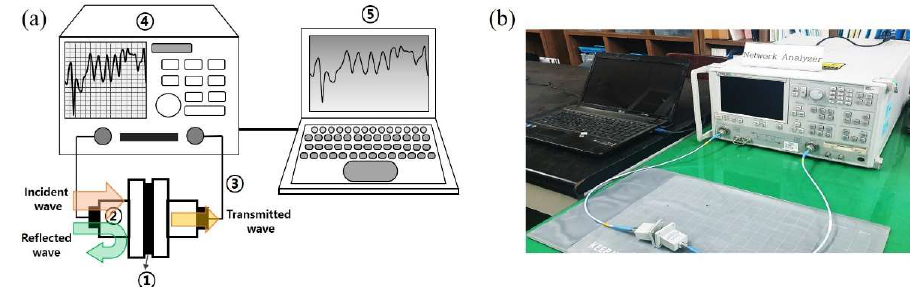
Figure 12. ( a ) Schematic of the vector network analyzer (VNA): ① sample, ② waveguide test hold- ers, ③ coaxial cables, ④ VNA, and ⑤ computer and ( b ) optical photograph of the experimental setup for the EMI shielding measurements.